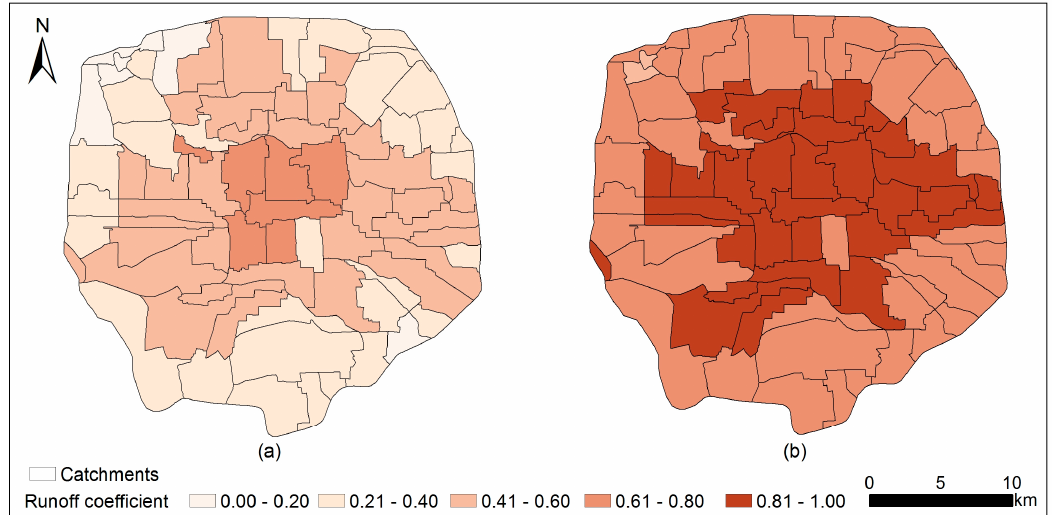
Figure 6. Spatial distribution characteristics of surface runoff with the rainfall return periods of ( a ) 1a and ( b ) 100a under land use condition of 2019.